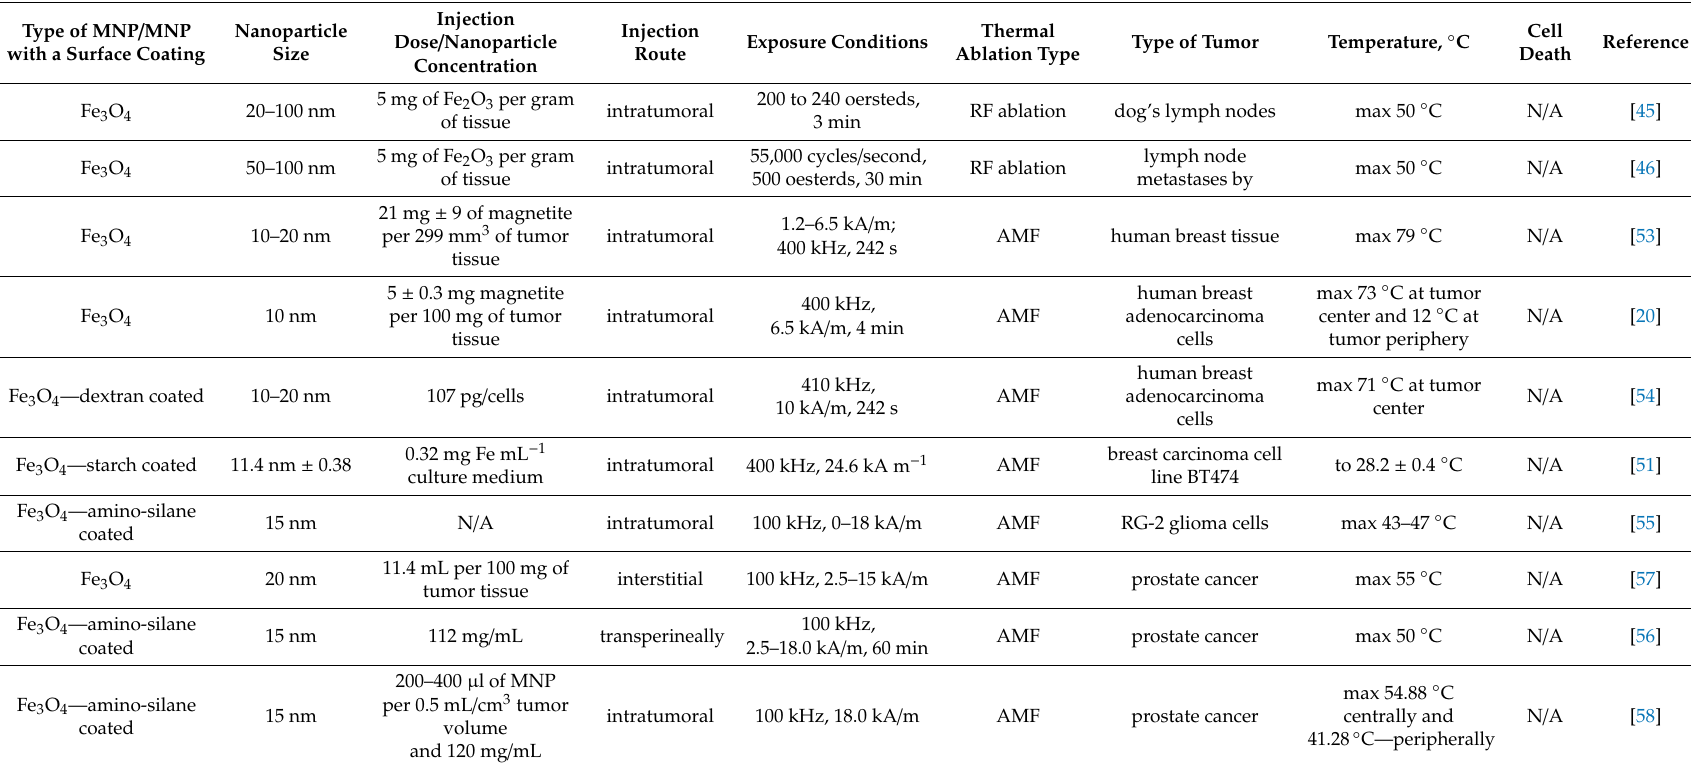
Table 1. Summary of MNPs application in thermal ablation of